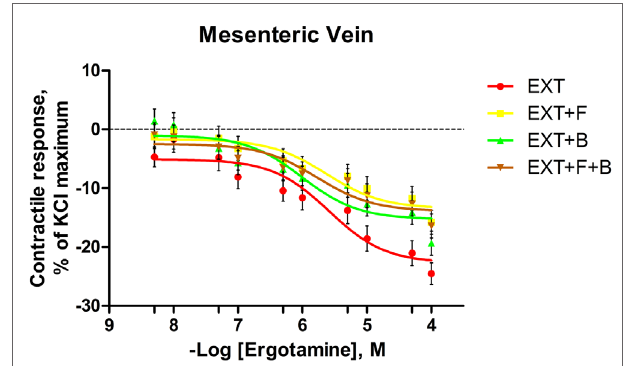
FigUre 5 | Mean contractile response, as % Kcl maximum of mesenteric vein to increasing concentrations of ergotamine for pretreatments with tall fescue seed extract: 1 × 10 − 6 M ergovaline- containing tall fescue seed extract (eXT); combinations of 1 × 10 − 6 M eXT and 1 × 10 − 6 M F (eXT + F ); 1 × 10 − 6 M eXT and 1 × 10 − 6 M B (eXT + B ); or 1 × 10 − 6 M eXT and 1 × 10 − 6 M F and 1 × 10 − 6 M B (eXT + F + B ) . The regression lines were plotted for each treatment using a non-linear regression with fixed slope, and the sigmoidal concentration response curves were calculated by the following equation: